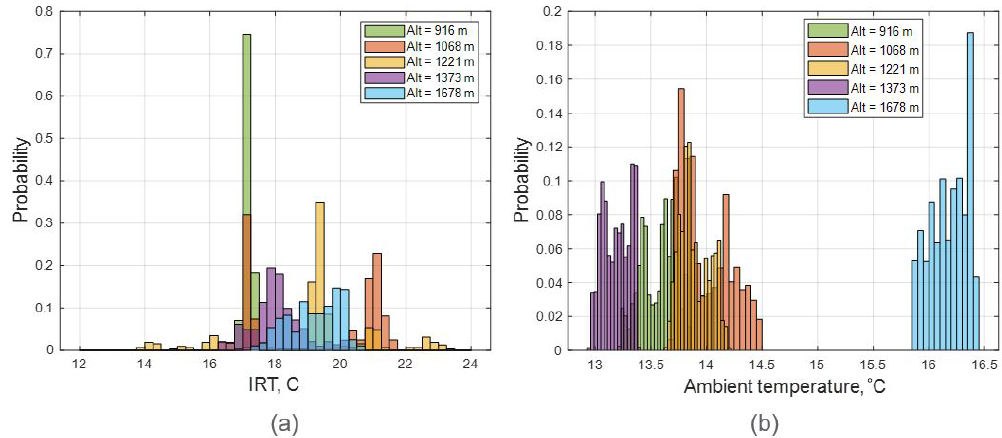
Figure 12. Histogram plots of IRT (a) and ambient temperature (b) at each “level” flight leg on 9 November